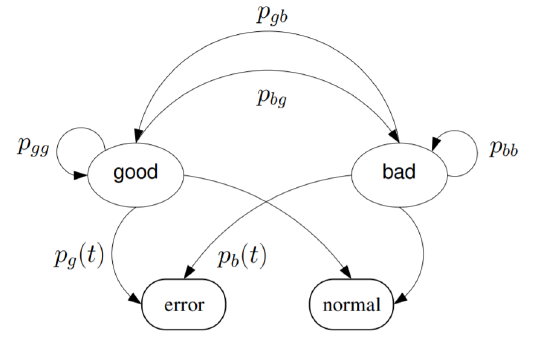
Figure 5. State transition diagram based on a two-state Markov process